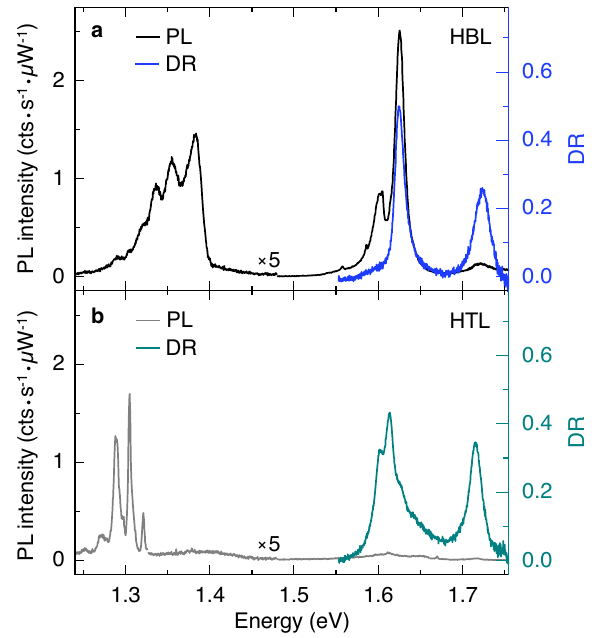
Fig. 1 Cryogenic photoluminescence and differential re fl ectivity spectra of MoSe 2 -WSe 2 heterobilayer and heterotrilayer. a , b Photoluminescence (black and gray) and differential re fl ectivity (blue and dark cyan) spectra of twisted HBL and HTL MoSe 2 -WSe 2 at 3.2 K. The luminescence was excited with linearly polarized excitation laser at 1.85 eV and scaled in intensity below 1.47 eV by a factor of 5 in both